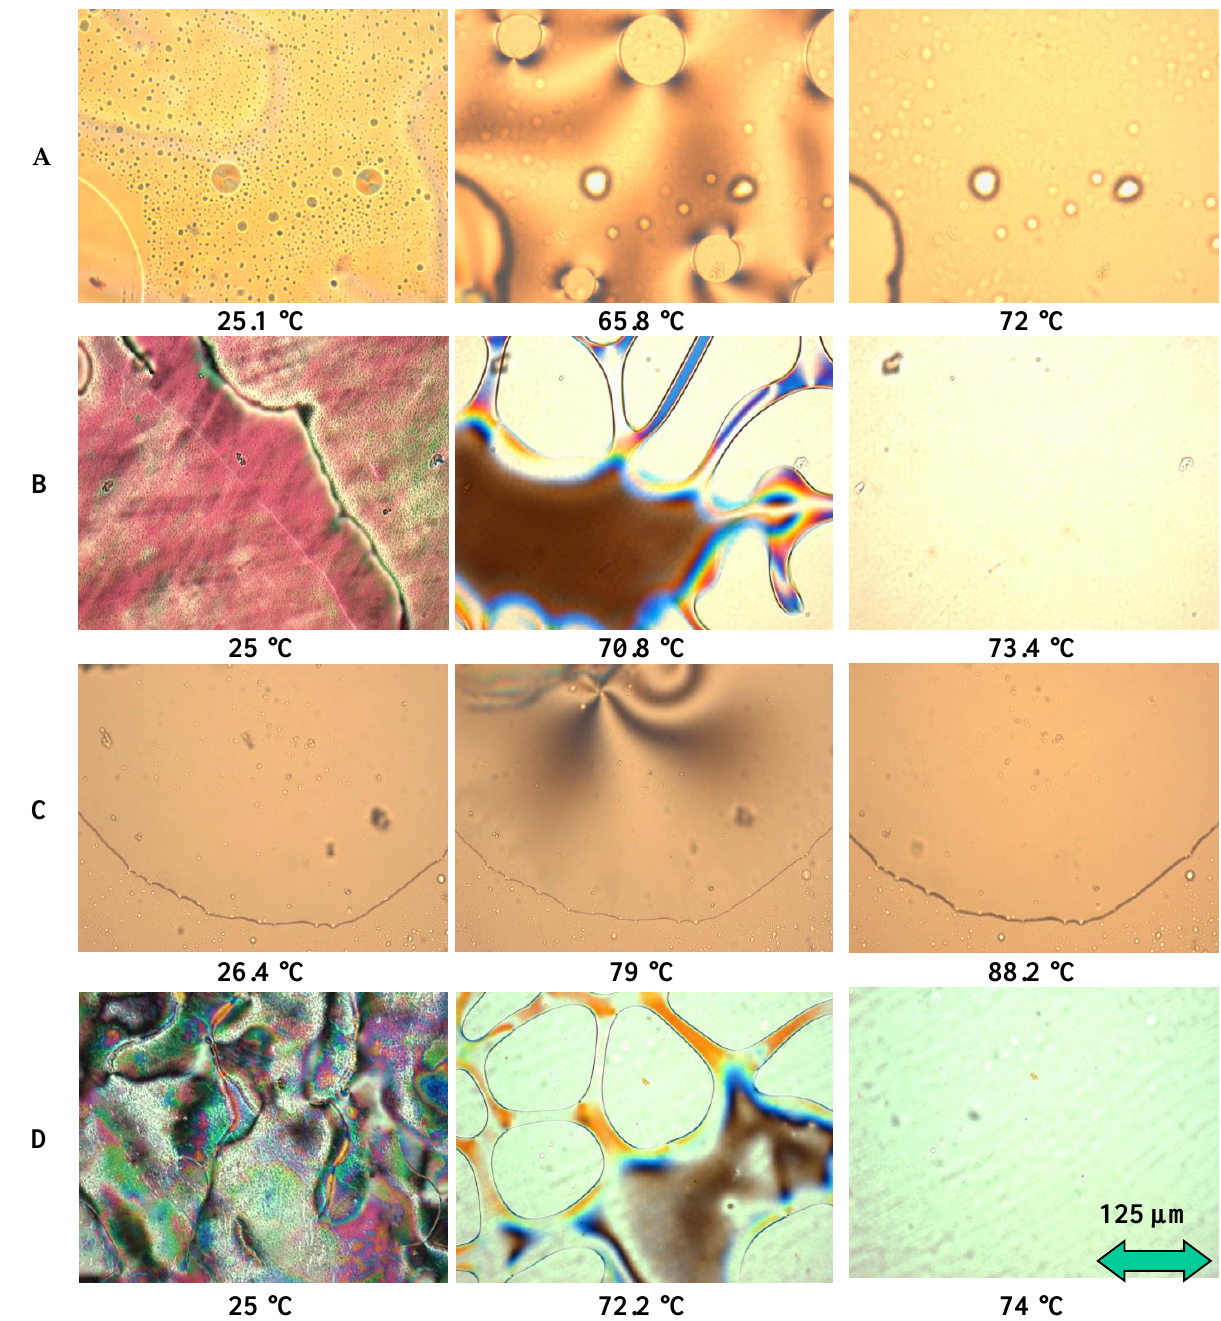
Figure 9. POM results from LC mixtures of EOL-LCDs A, B, C and D. Table 4. Mesomorphic and thermal properties of LCs extracted from LC mixtures of EOL-LCDs A, B, C and D.